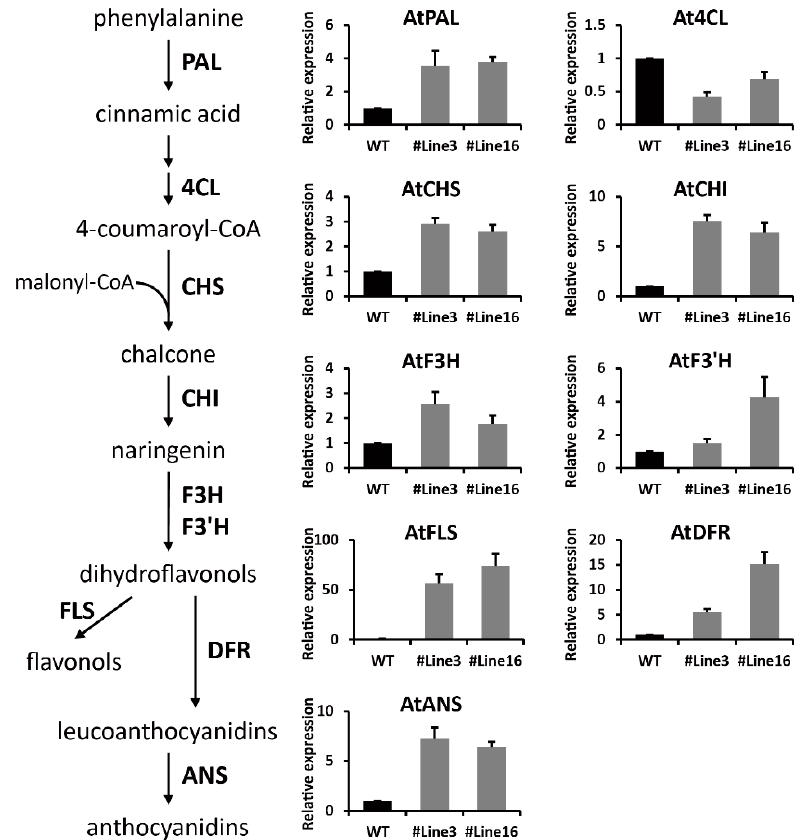
Figure 6. Transcriptional levels of flavonoid biosynthetic genes in WT and transgenic Arabidopsis.